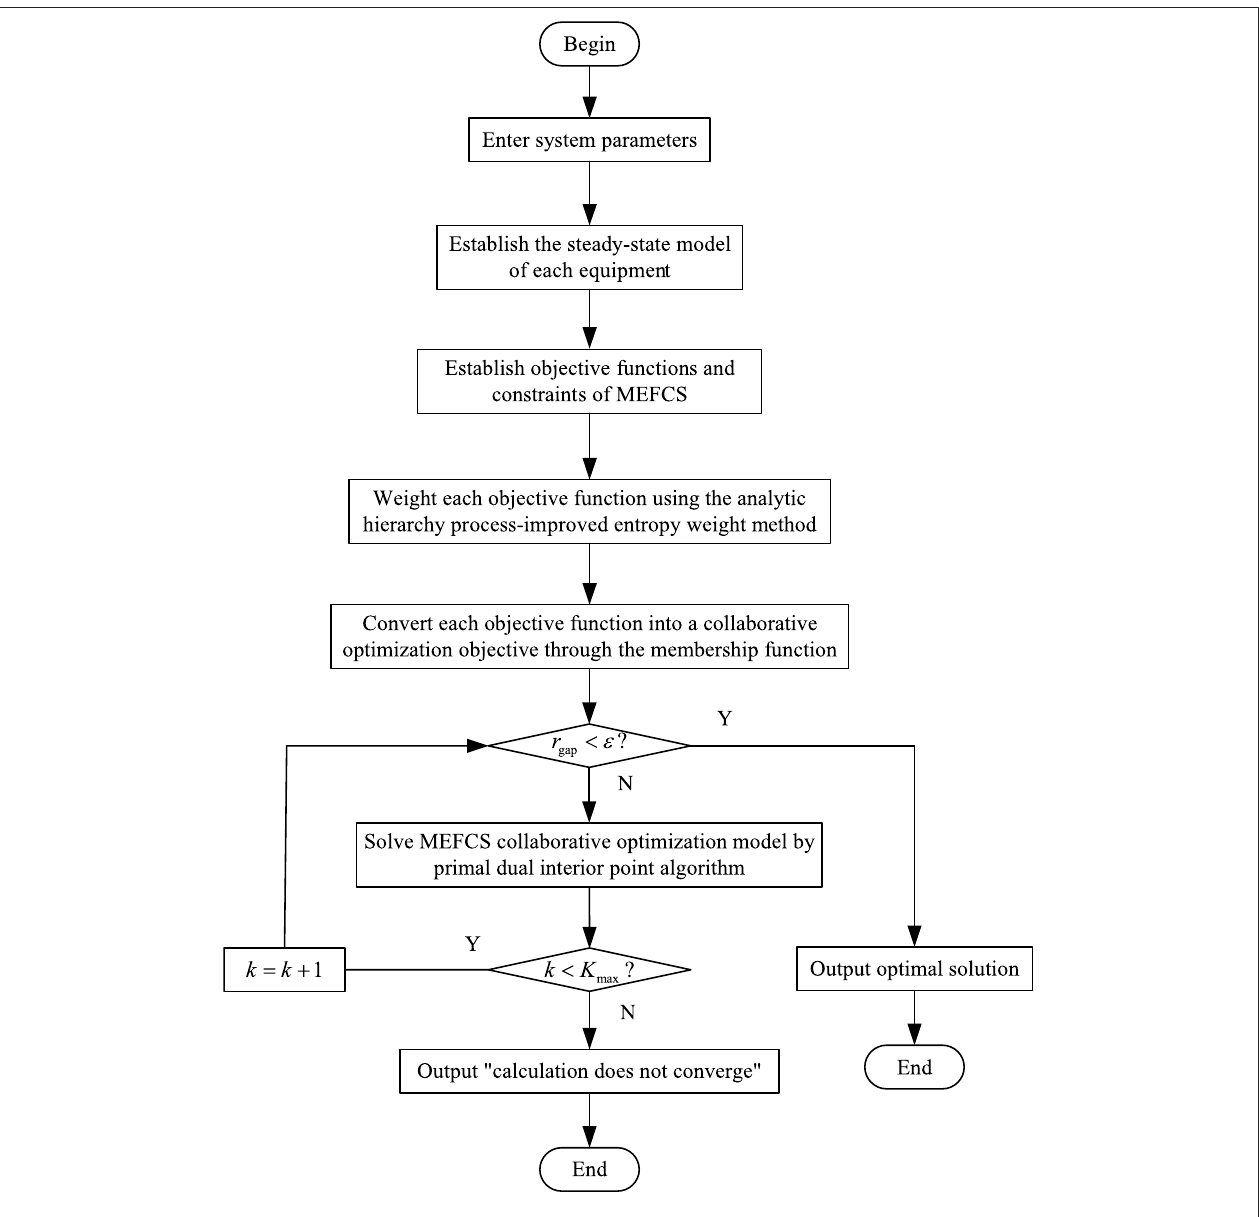
FIGURE 3 | Flowchart of the collaborative optimization of